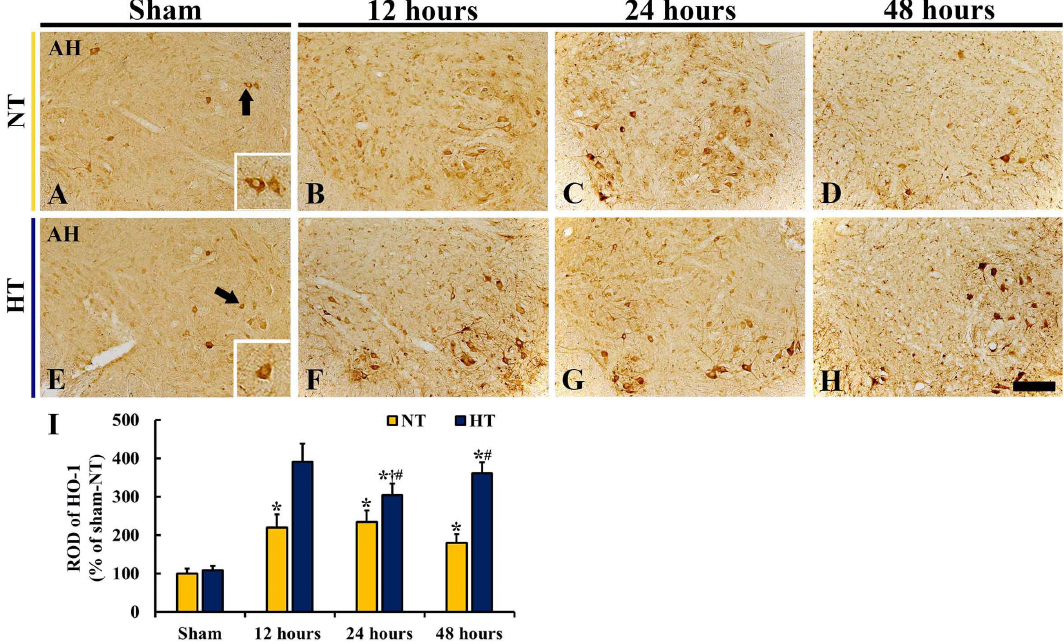
Figure 7. ( A – H ) HO-1 immunohistochemistry in the anterior horn of the sham-NT ( A ), CA-NT ( B – D ), sham-HT ( E ), and CA-HT ( F – H ) groups at 12 ( B , F ), 24 ( C , G ), and 48 ( D , H ) hours after CA/ROSC. HO-1 immunoreactivity is shown in motor neurons (arrows and lower right box) in both sham groups. In the CA-NT group, HO-1 immunoreactivity peaks at 24 h and decreases at 48 h due to death of motor neurons after CA/ROSC. The CA-HT group, HO-1 immunoreactivity peaks at 12 h after CA/ROSC and is significantly higher at all points in time after CA/ROSC than the CA-NT group. AH, anterior horn. Scale bar = 200 µm. (I) ROD of HO-1 + structures. The bars indicate the means ± SD ( n = 6, respectively; * p < 0.05 vs. each sham group; † p < 0.05 vs. previous time-point group; # p < 0.05 vs. corresponding CA-NT group).